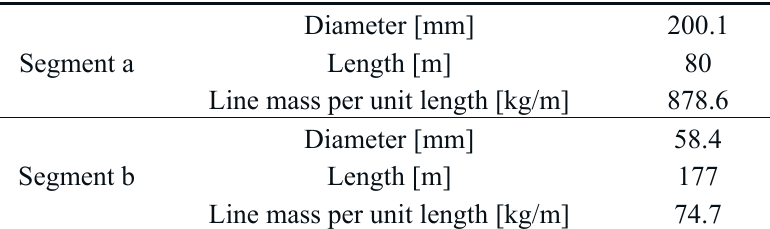
Table 3. Truncated mooring line characteristics.